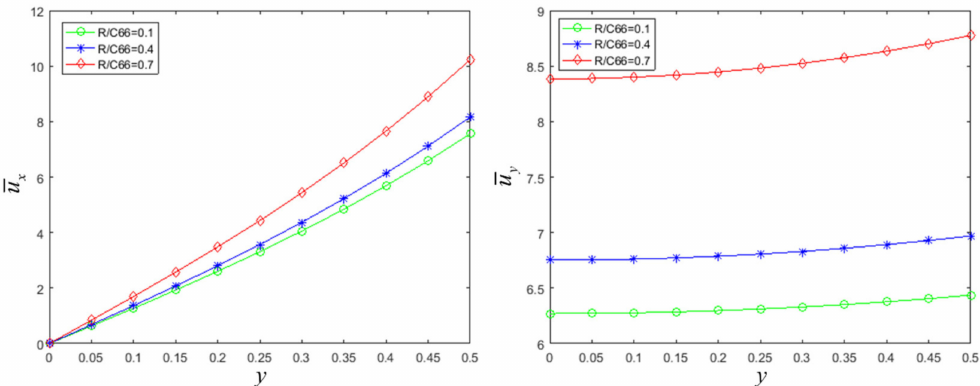
Figure 2. Normalized displacements of phonon field versus y at x =